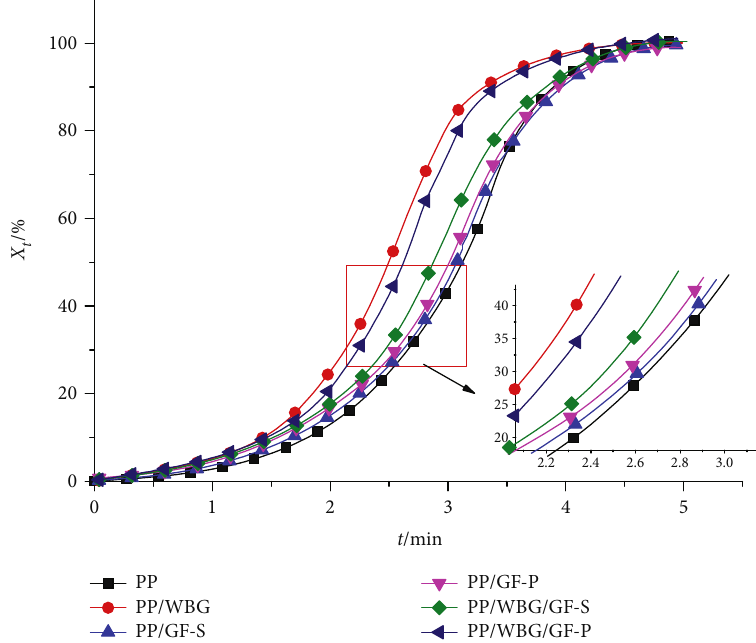
Figure 4: The variation in the relative degree of crystallinity ( X of 5 ° C/min.